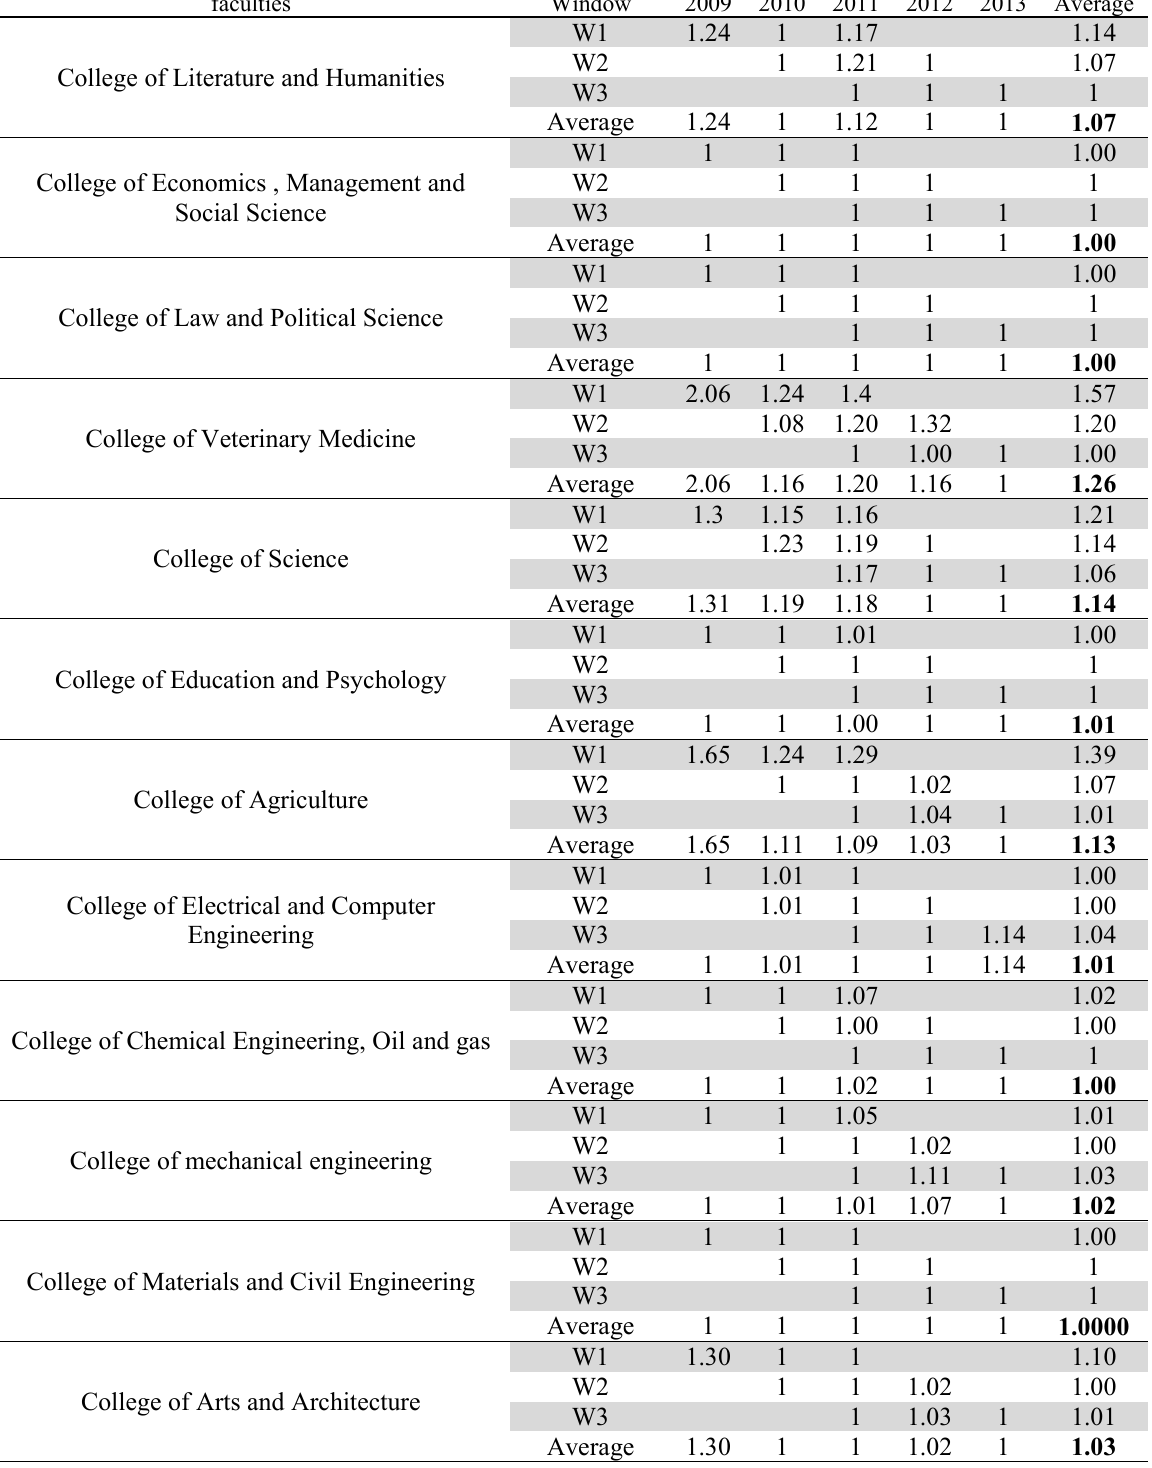
Table 3 Average Pessimistic analysis for separating the